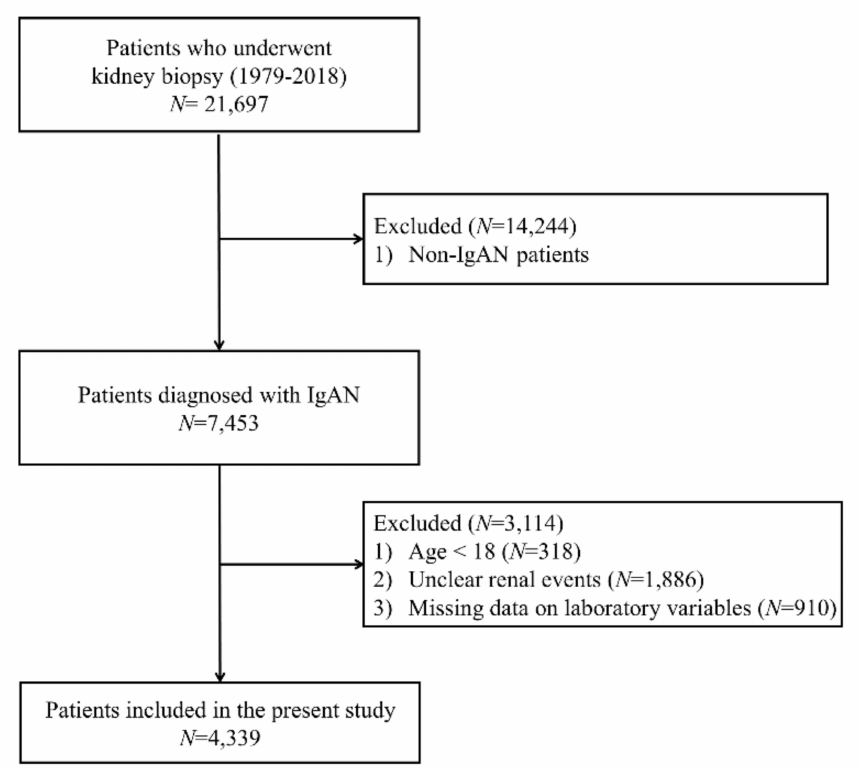
Figure 1. Flow diagram for patient’s enrollment. Abbreviation: IgAN, immunoglobulin A